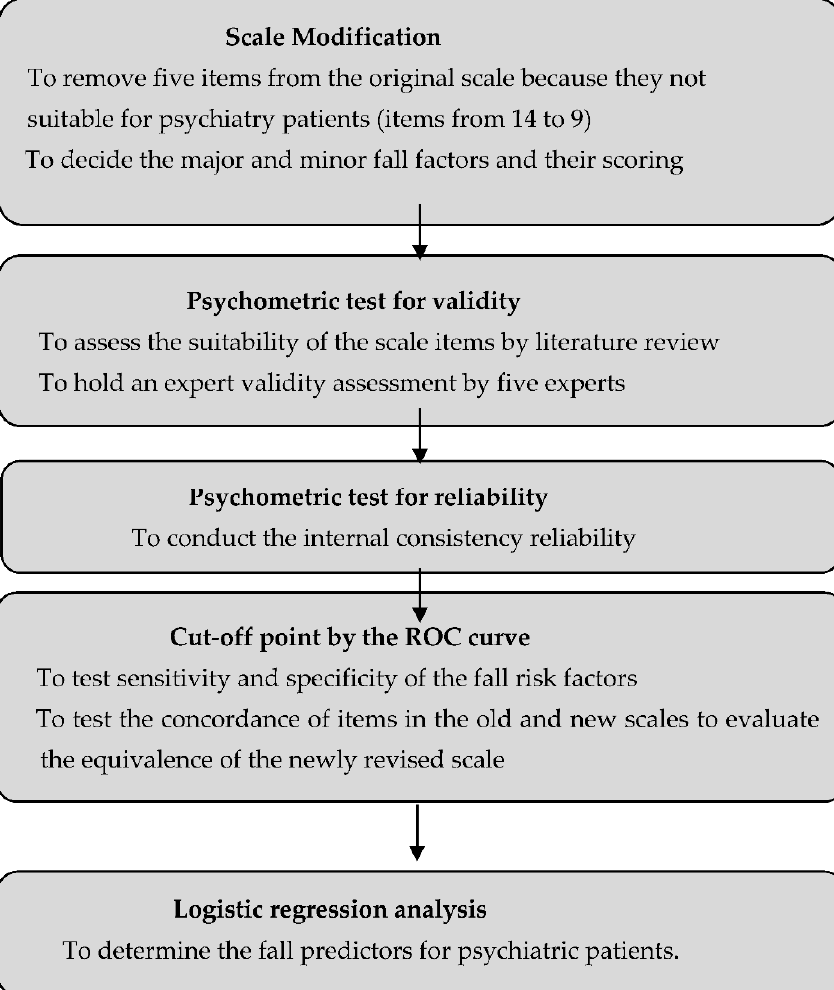
Figure 1. The different phases of the study.